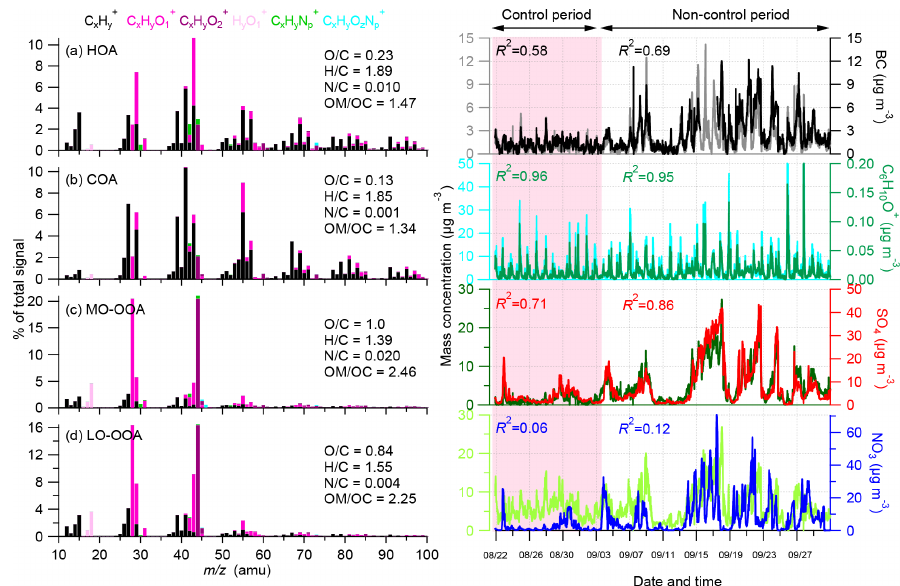
Figure 3. High-resolution mass spectra (left panel) and time series (right panel) of four OA factors at the ground site: (a) hydrocarbon-like OA (HOA), (b) cooking-related OA (COA), (c) more oxidized oxygenated OA (MO-OOA) and (d) less oxidized OOA (LO-OOA). The time series of BC, sulfate and nitrate are shown for comparisons, and the correlation coefficients ( R 2 ) between OA factors and external tracers during the control (pink area) and non-control periods are also shown. The elemental ratios in the left panel were calculated from the I-A method (Canagaratna et al.,